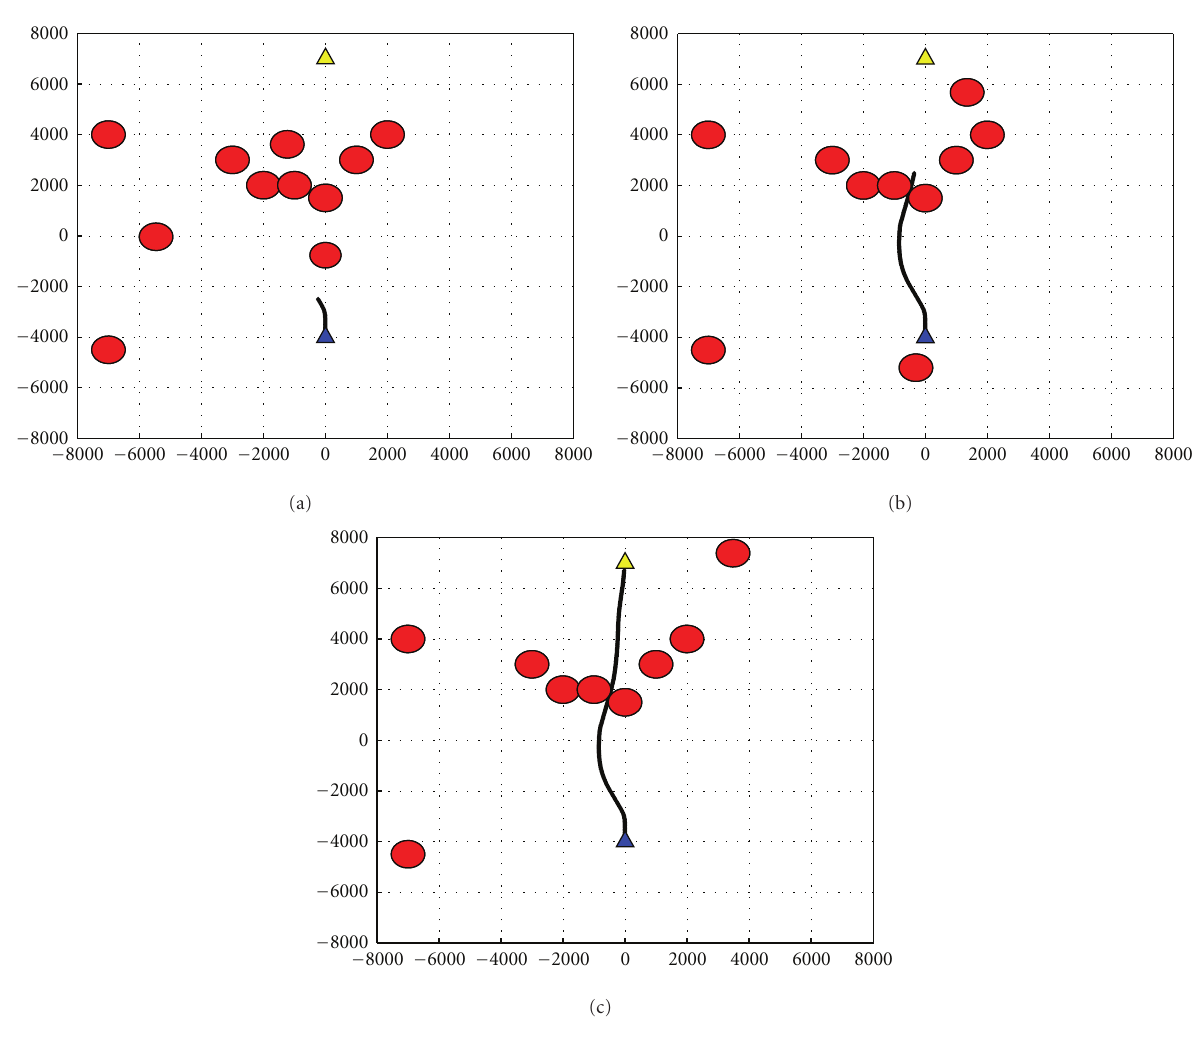
Figure 4: Simulation in crowded dynamic environment P safe = 0 . 6.